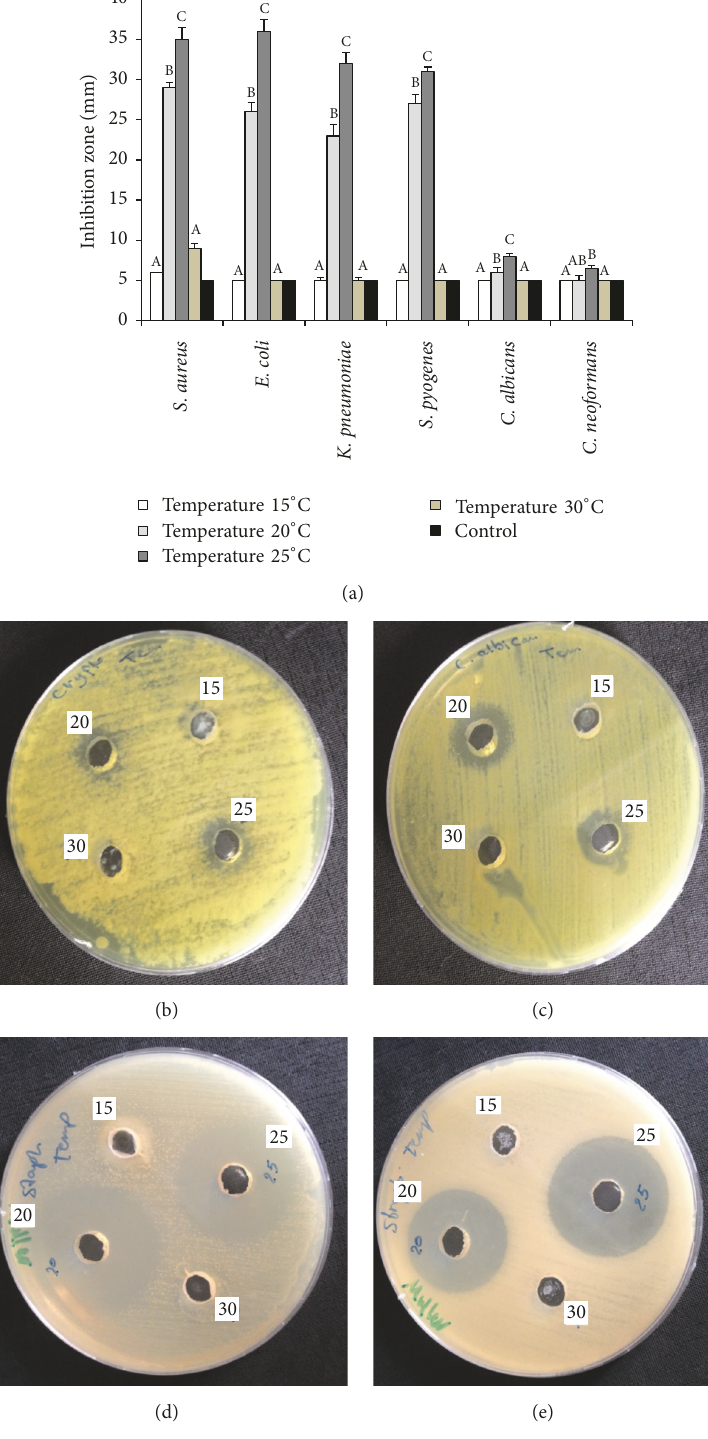
Figure 4: (a) Effect of different temperatures on the production and killing activity of killer toxin produced by D. hansenii against pathogenic bacteria and yeasts. Killer activity was measured by the means of inhibition zones around the wells filled with partially purified and concentrated killer toxin. (b) C. neoformans , (c) C. albicans , (d) S. pyogenes , and (e) S. aureus . Values in the same column followed by the same letter are not statistically different by Duncan’s multiple range test at ( 𝑝 < 0.05